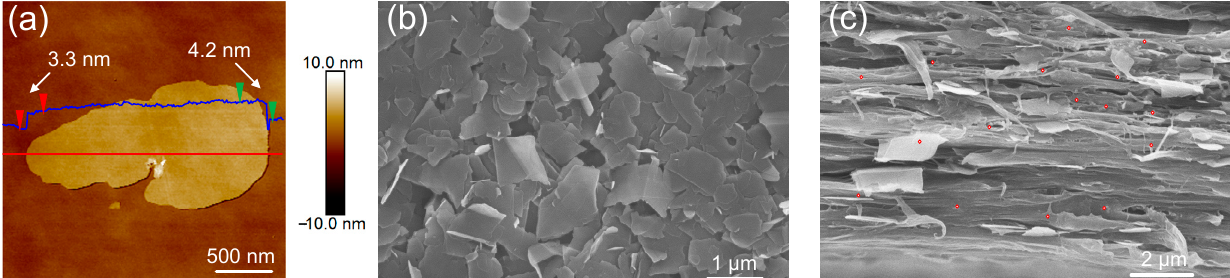
Figure 1. ( a ) AFM image of BNNSs and section analysis along the red line showing the sheet thickness. SEM images of ( b ) BNNSs and ( c ) cross-sectional SEM image of the ternary nanocomposite films containing 6 vol.% BNNS and 3 vol.% BT. The location of some BT nanoparticles in SEM images is circled in red.